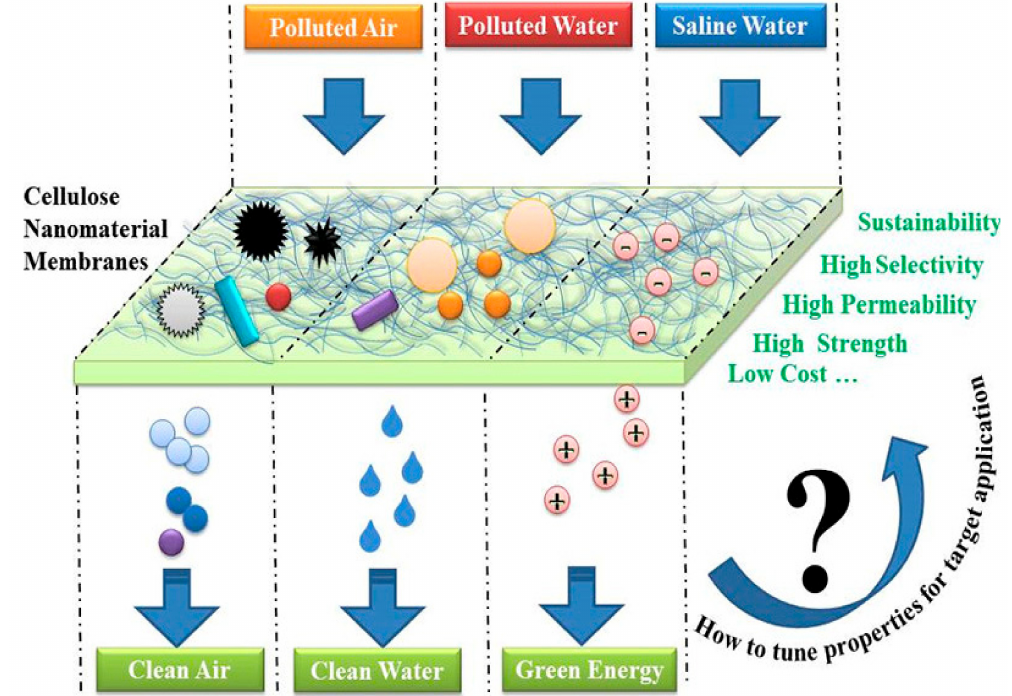
Figure 4. Schematic illustration of using cellulose nanomaterials for achieving clean air, water, and green energy. Figure reproduced from [157] with permission from